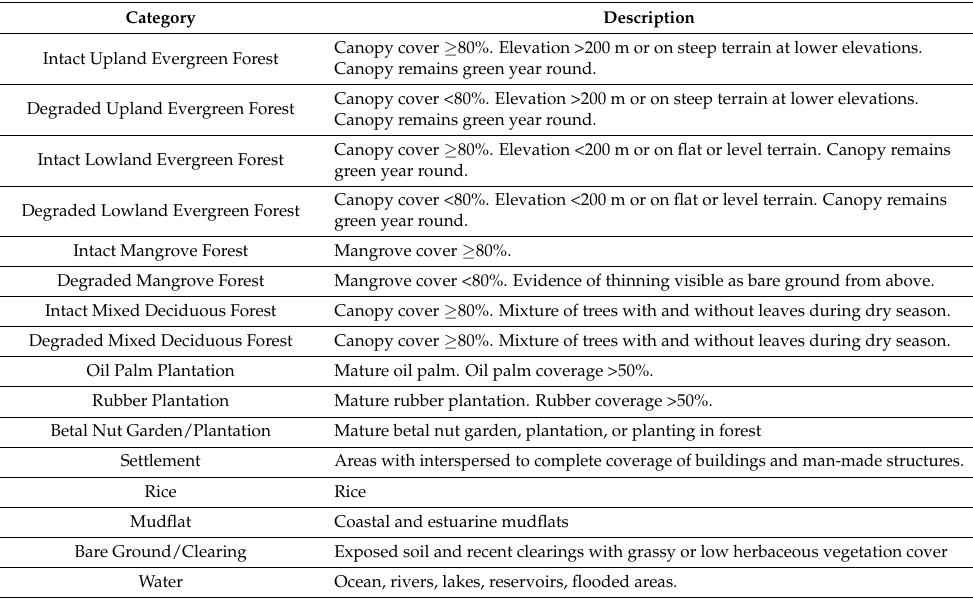
Table 1. Tanintharyi land use and land cover